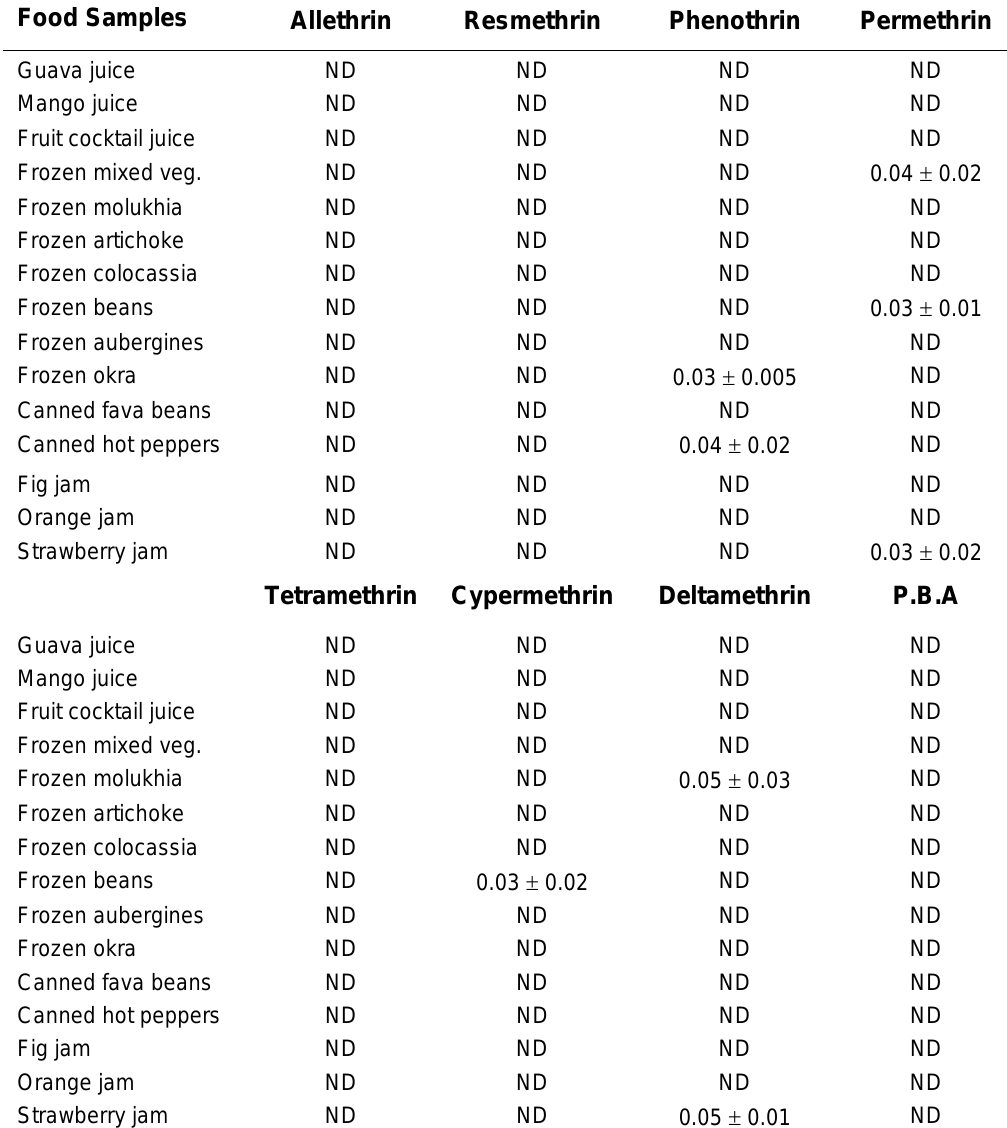
Pyrethroid Residues (ppm) and RSD in Food Samples Extracted by SFE and Determined by SFC/UVD at 220 nm Pyrethroid Residues (ppm ± RSD)